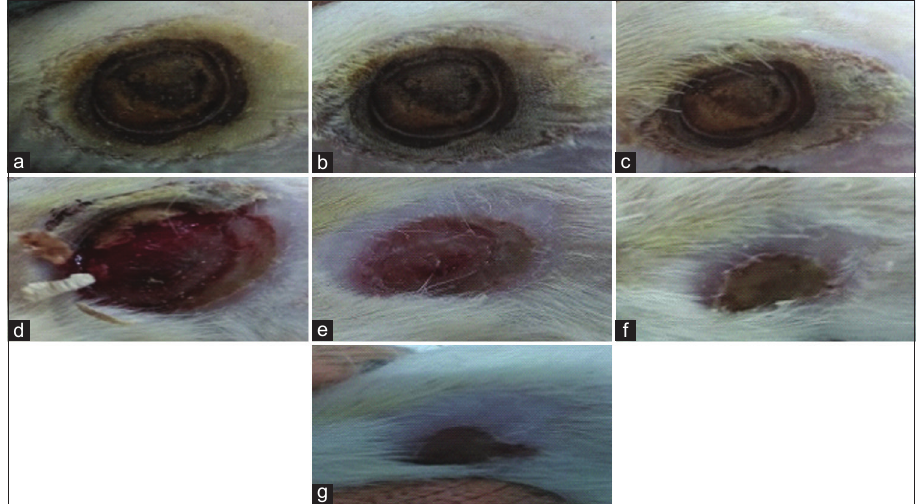
Figure-1: Clinical progression of third-degree burn wound healing on Sprague–Dawley rat; (a) wound on day 0 a moment after induction; (b) wound on day 4, there was no significant difference observed; (c) wound on day 8, there was no significant difference observed but scab was starting to be formed; (d) wound on day 12, scab was nearly off; (e) wound on day 15, redness was beginning to fade and the wound diameter was shorter than before; (f) wound on day 18, wound became dry and the diameter was reduced further; (g) wound on day 21, wound diameter was reduced further but the wound healing was not completed yet.